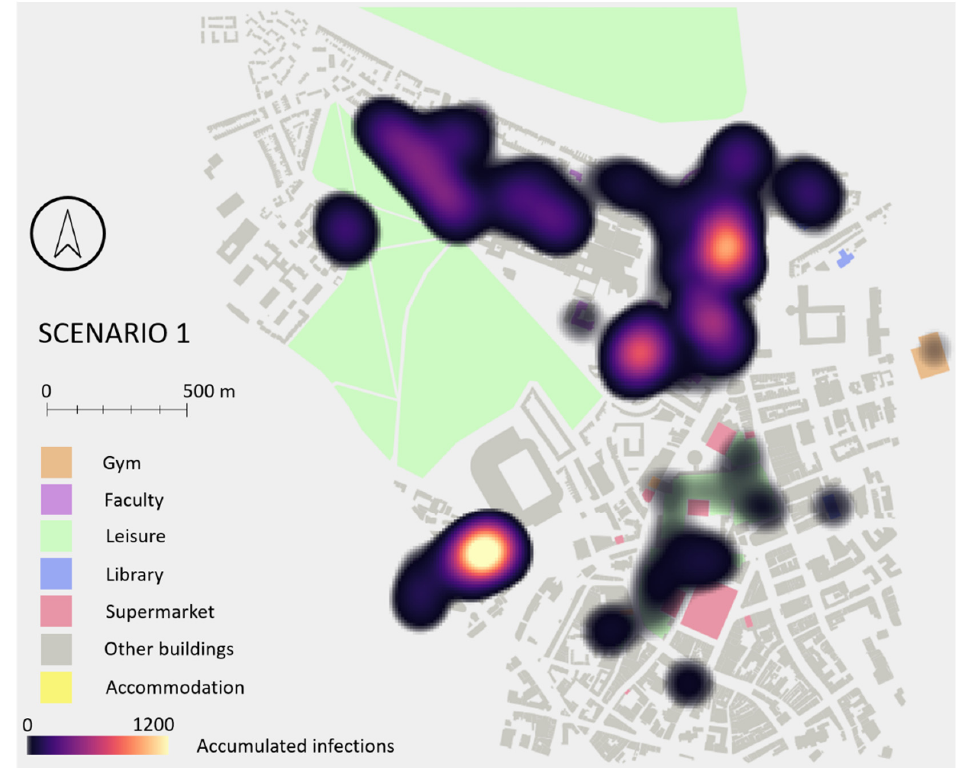
Figure 14. Heat map for Scenario 1 showing the areas (in light yellow) where more infections were produced. Two main hotspots are visible, one in the SE where two student accommodations and a busy supermarket are located, and the other in the main campus where most faculty buildings and another busy supermarket are located. Contains Ordnance Survey data © Crown copyright and database right 2020.